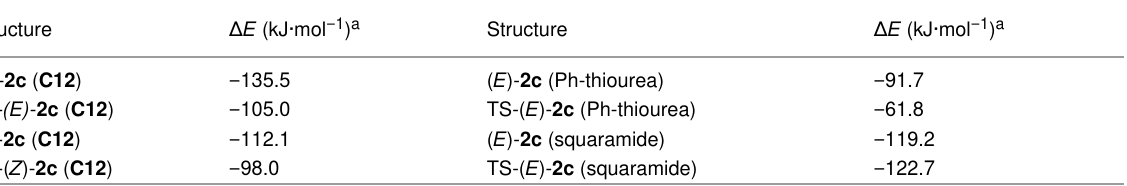
Table 6: Comparison of DFT-calculated interaction energies between starting silyl ketene acetal/transition state structure and catalysts. Structure